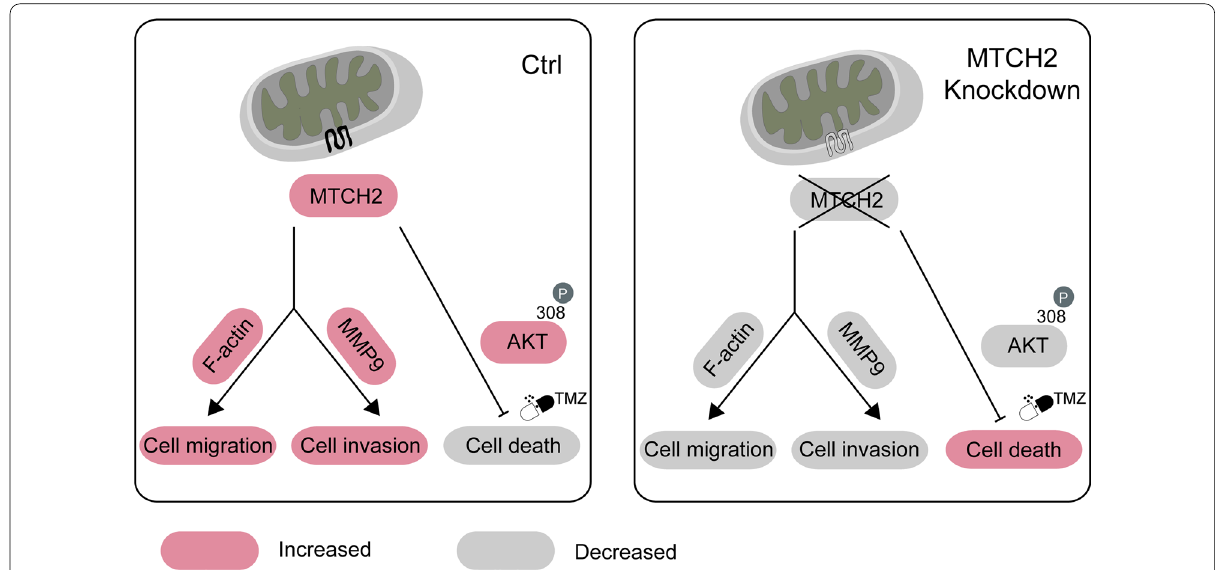
Fig. 7 Model. A schematic demonstrates that MTCH2 regulates cell invasion/apoptosis of malignant gliomas. Silencing of MTCH2 expression impairs cell migration via F-actin depolymerization, decreases cell invasion via MMP-9 pathway, and represses pro-survival AKT signaling to promote TMZ-induced cell